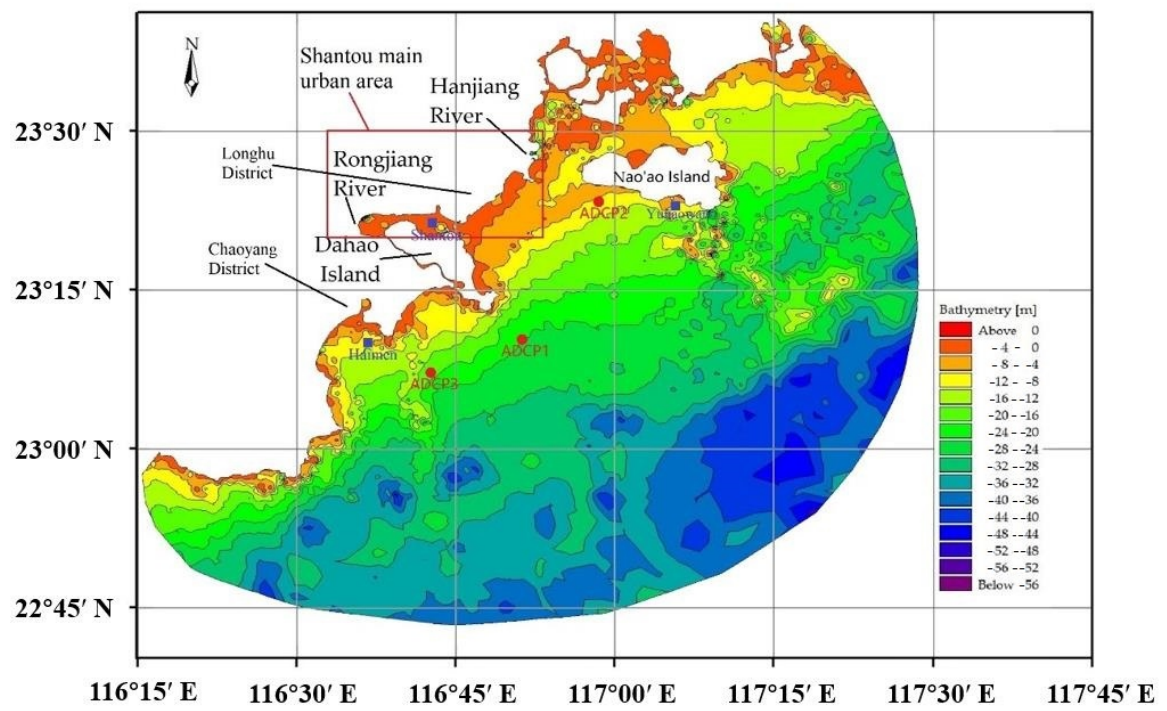
Figure 1. Study area and oceanographic station location. (The blue squares are the tide stations; the red circles are the ADCP points).